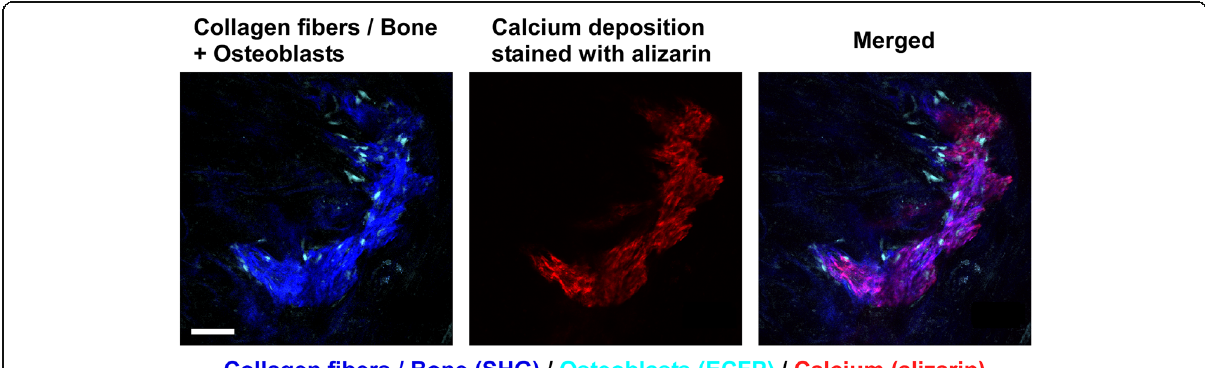
Fig. 3 Representative intravital two-photon microscopy images of ectopic bone formation area in Col2.3-ECFP mice (visualization of calcium deposition). Visualization of osteoblasts, newly formed bone (collagen), and calcium deposition stained with alizarin after implantation of a collagen sponge containing BMP-2 [15]. Cyan, osteoblasts expressing Col2.3-ECFP; red, calcium deposition stained with alizarin; blue, collagen fibers (second harmonic generation, SHG). Scale bar, 100 μ